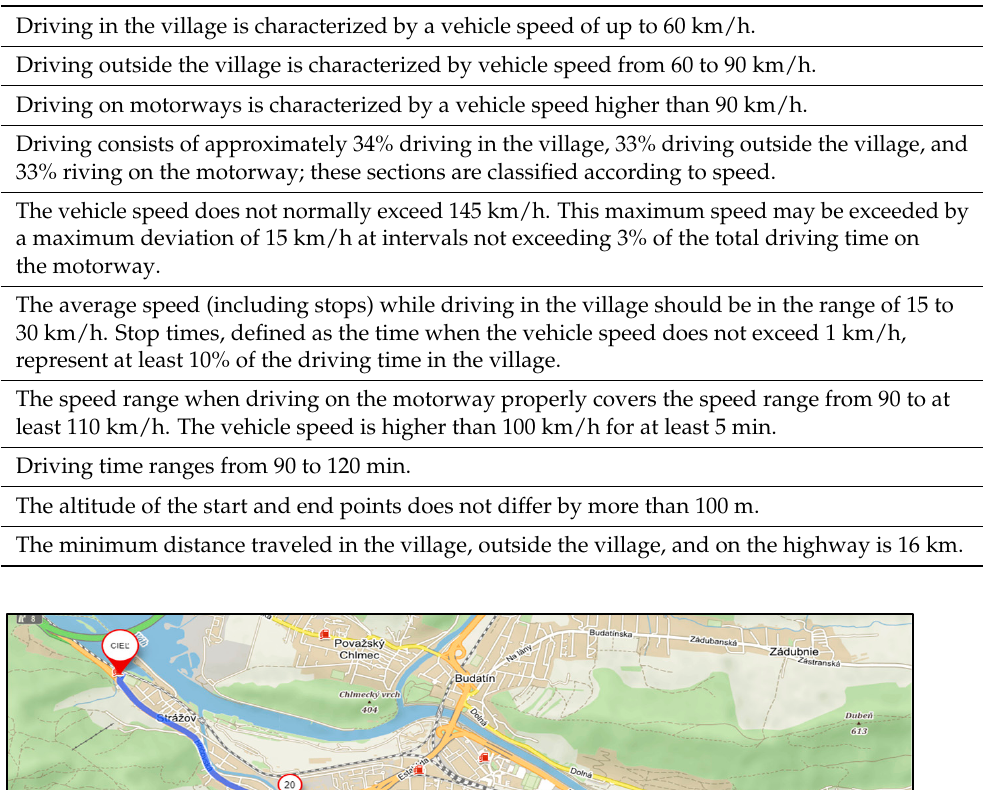
Table 1. RDE driving requirements [27].